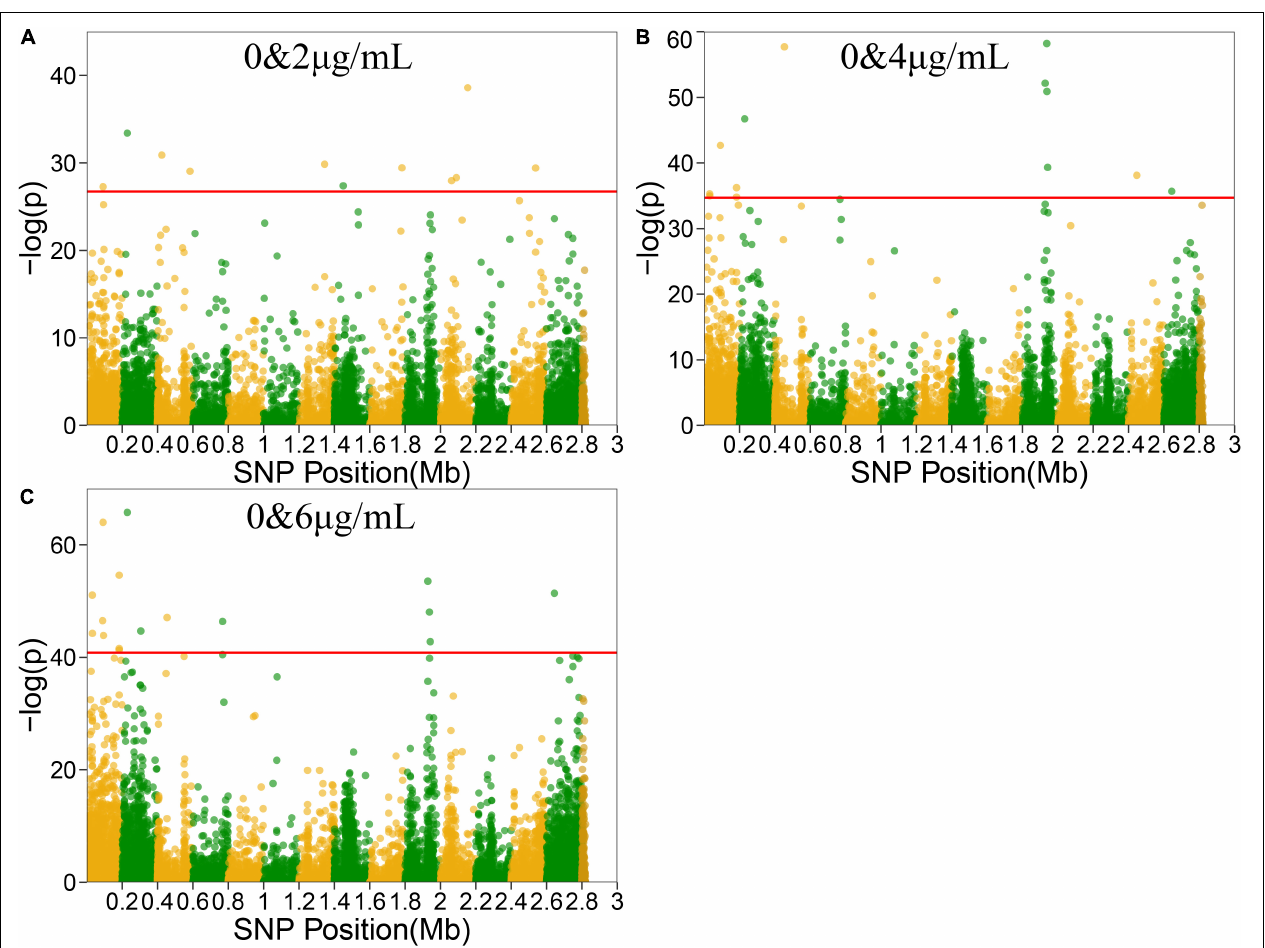
FIGURE 3 | Manhattan plots of bivariate functional mapping. Manhattan plot of the significance test based on the associations between phenotypic plasticity of microbial growth in the environment with or without antibiotics and SNPs. Each dot in the plot represented an SNP, and a reference line was used on the y -axis to reflect genome-wide significance. (A–C) Bivariate analysis of Manhattan plots with 0 and 2 µ g/mL, 0 and 4 µ g/mL, or 0 and 6 µ g/mL vancomycin